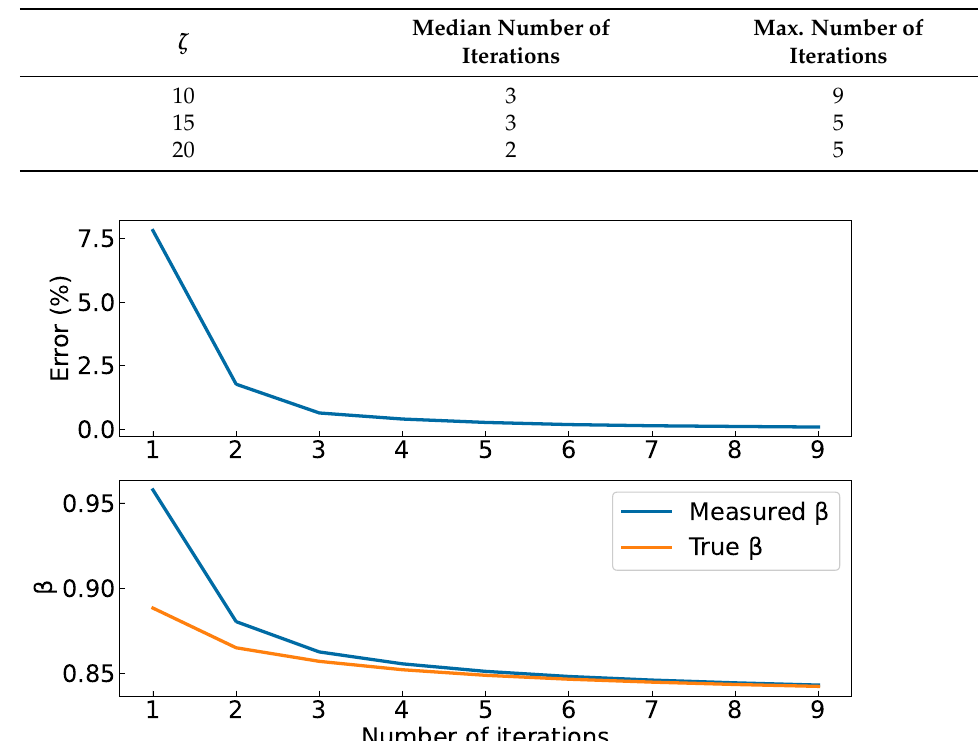
Table 3. Number of iterations required to correct the inflow speed in Case A.